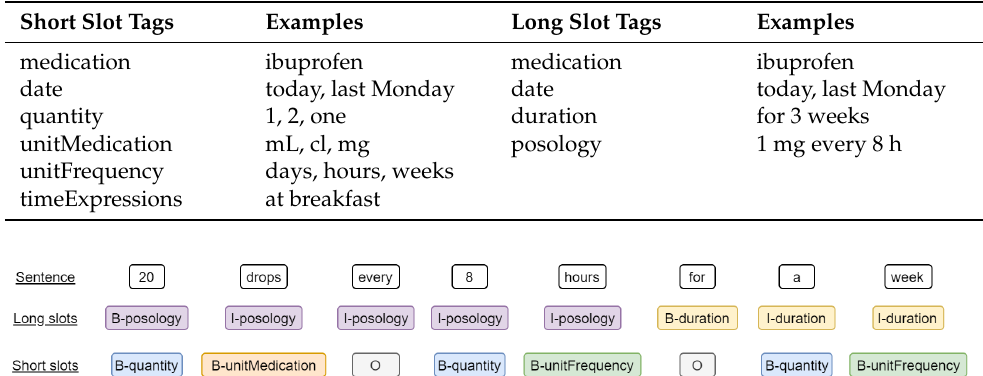
Table 3. Short and long slots proposed for the medication management scenario.